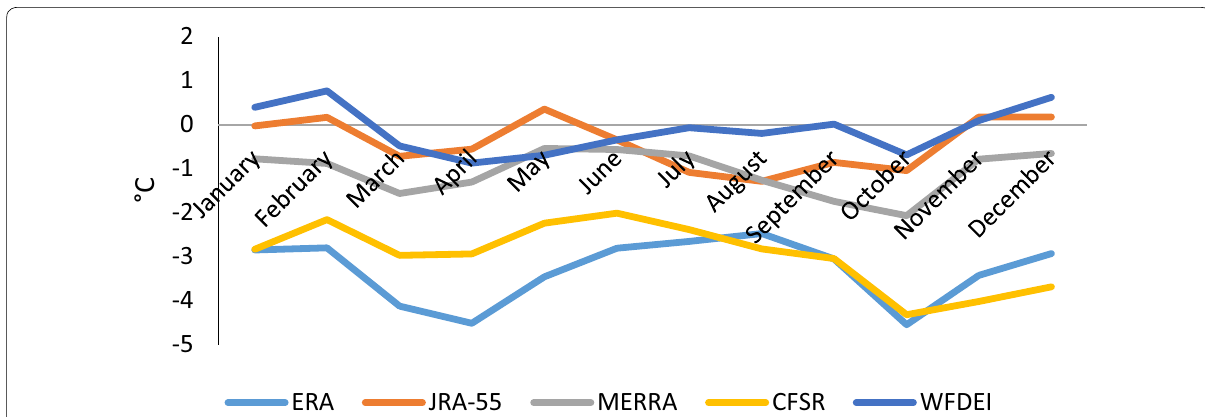
Fig. 10 Average monthly bias of mean temperature of Beas river basin for gridded and CRU temperature